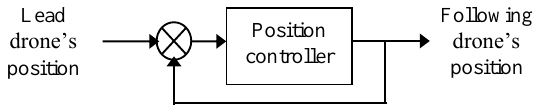
Fig. 1. A structure of the drone-following